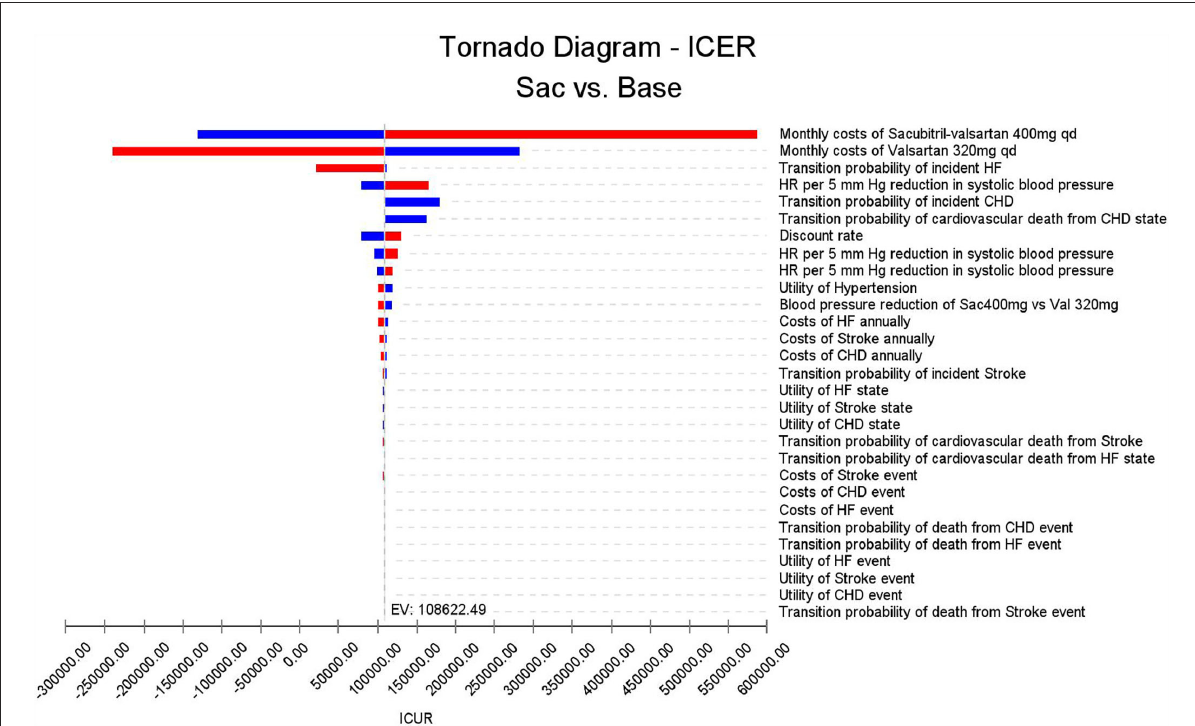
FIGURE3 Tornado diagram based on the one-way sensitivity analysis. Costs of sacubitril-valsartan and costs of valsartan impact the largest on the ICUR fluctuation; other input parameters impact little on ICUR.